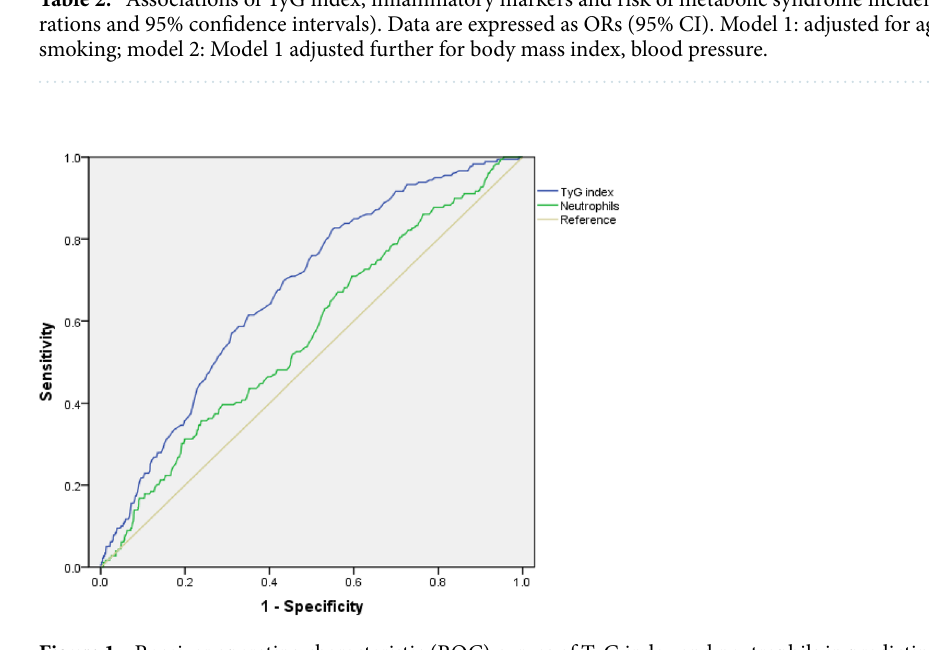
Figure 1. Receiver operating characteristic (ROC) curves of TyG index and neutrophils in predicting incident metabolic